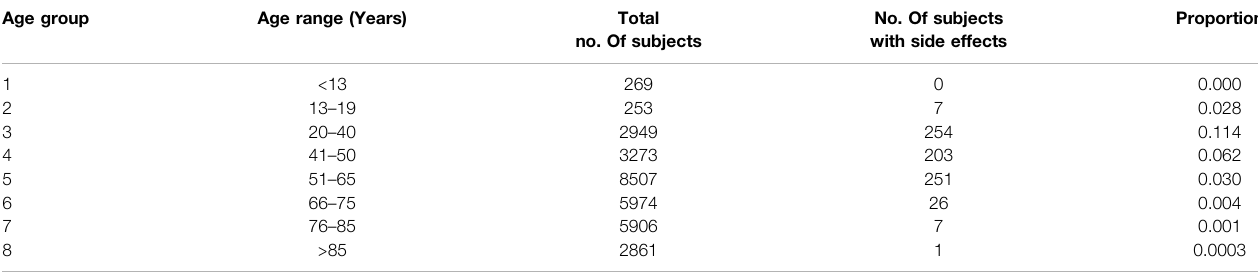
TABLE 2 | List of ICD 9 codes used for identifying subjects with adverse events. Broad category Opioid type or combination of opioid type with other drug